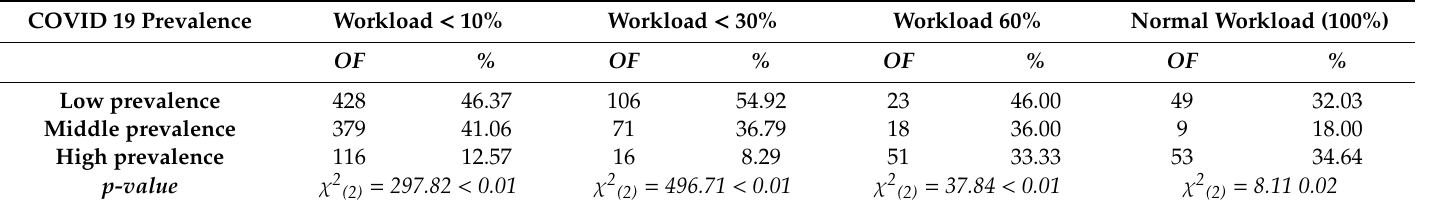
Table 3. Dentist working load (express in percentage) during the lockdown compared to the situation immediately before the workload, which corresponds to 100% work